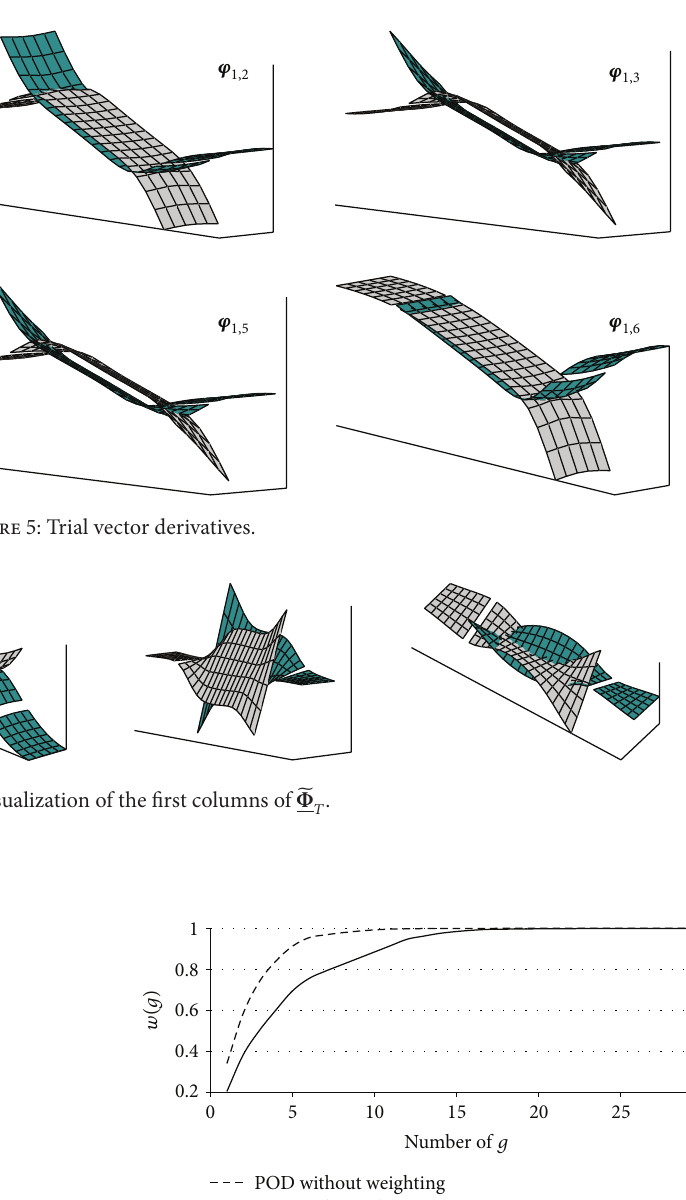
Figure 8: Evaluation of the function 𝑤(𝑔)